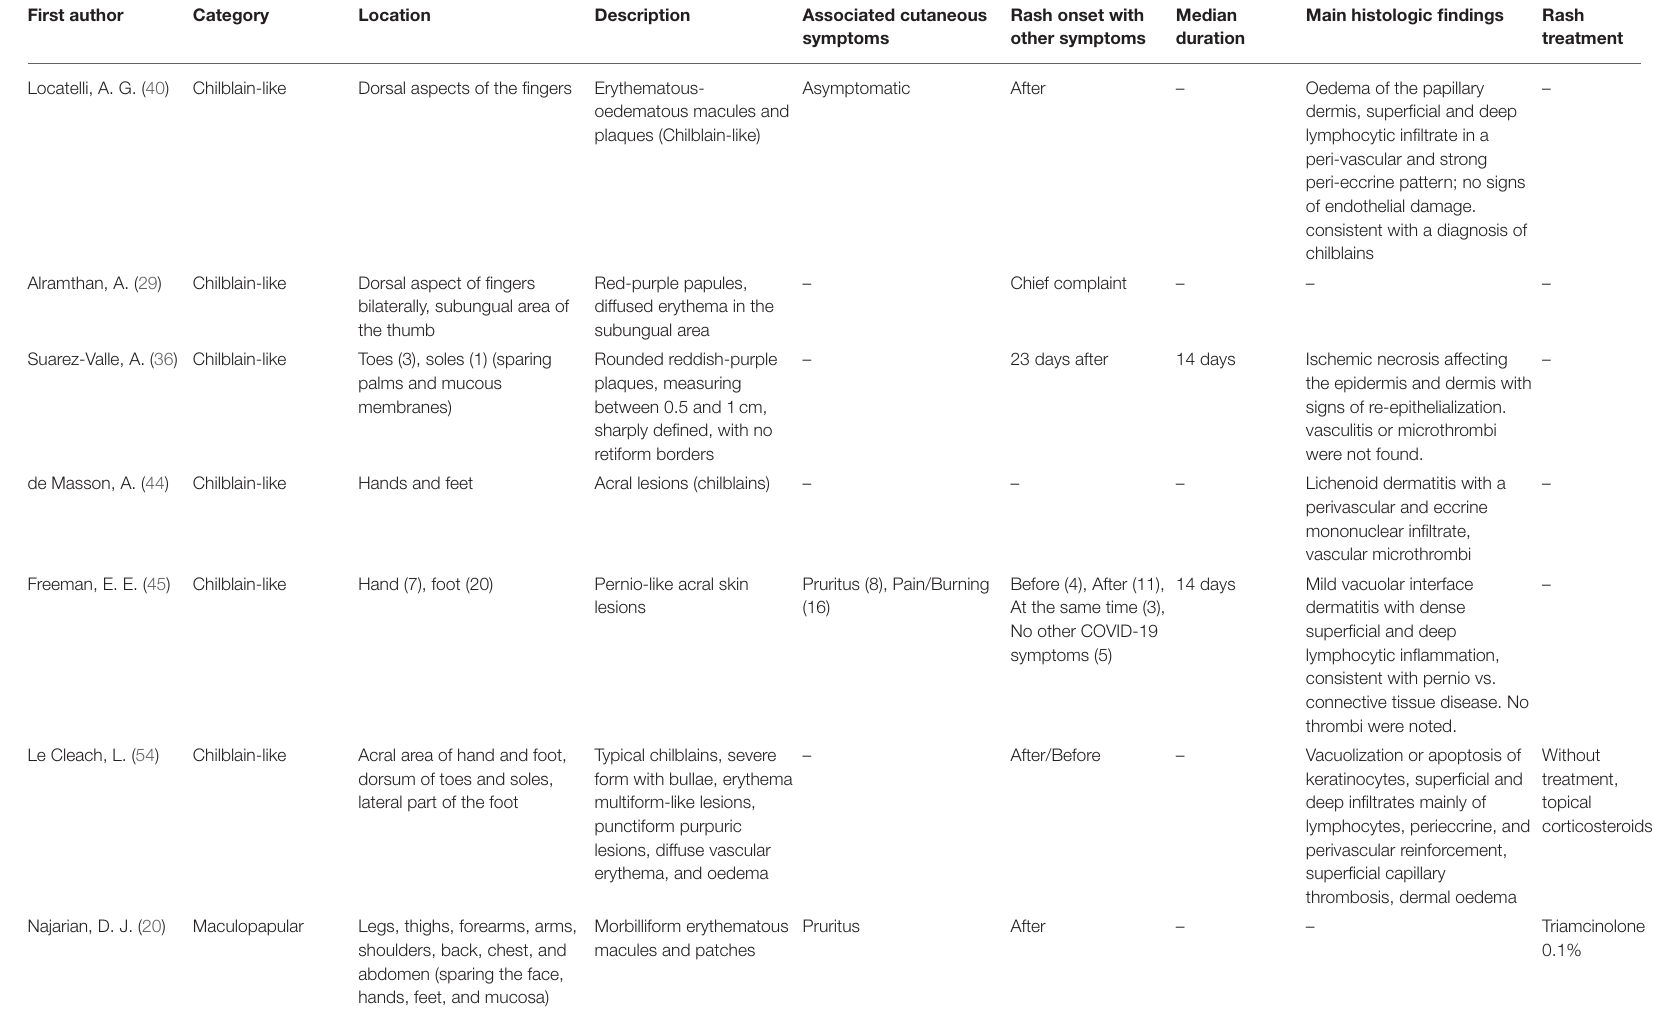
TABLE 2 | Characteristics of the cutaneous lesions in confirmed COVID-19